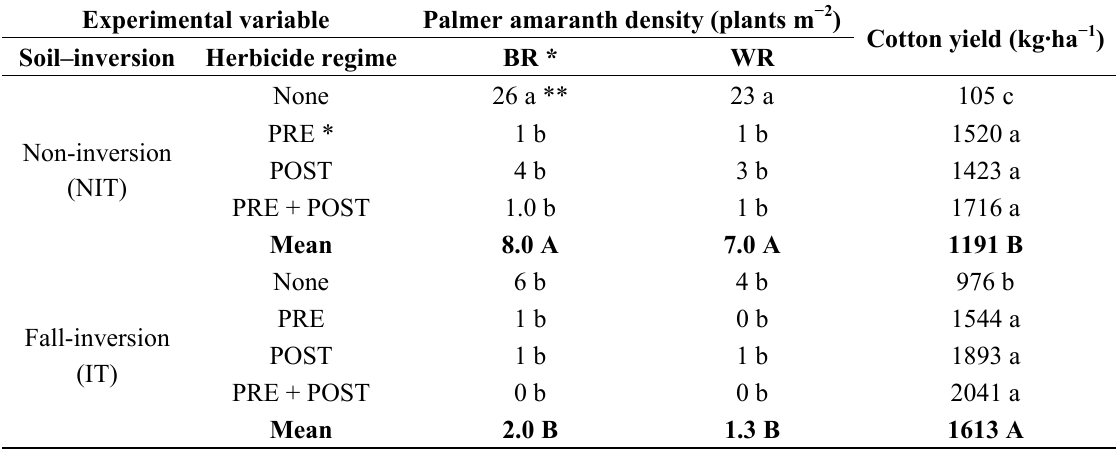
Table 3. Influence of soil–inversion and herbicide regime on Palmer amaranth density at 6 WAP * and cotton yield with cover crop and three production years’ data